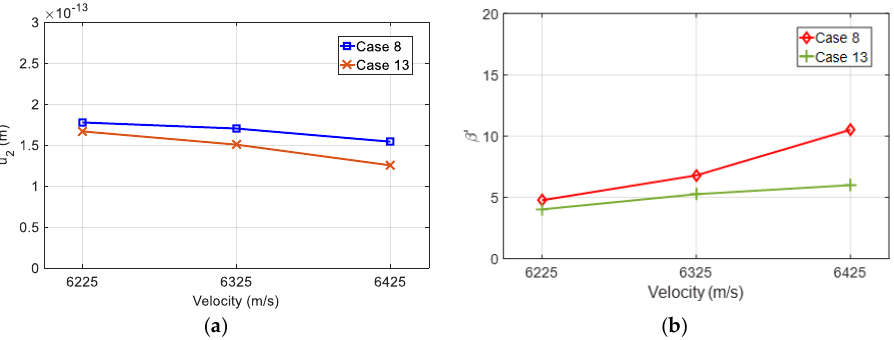
Figure 8. Effects of ∓ 100 m/s velocity change of the propagation medium on: ( a ) The second harmonic amplitude and ( b ) the uncorrected nonlinear parameter.